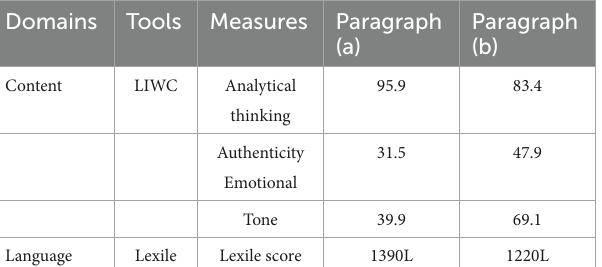
TABLE 2 Results of automated analyses of sample